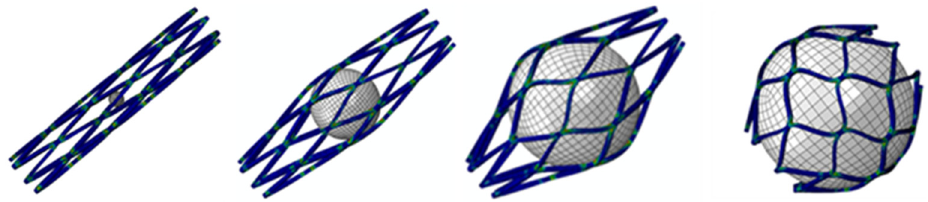
Figure 8. Contour plots of strain distribution during a series of spherical expansions.